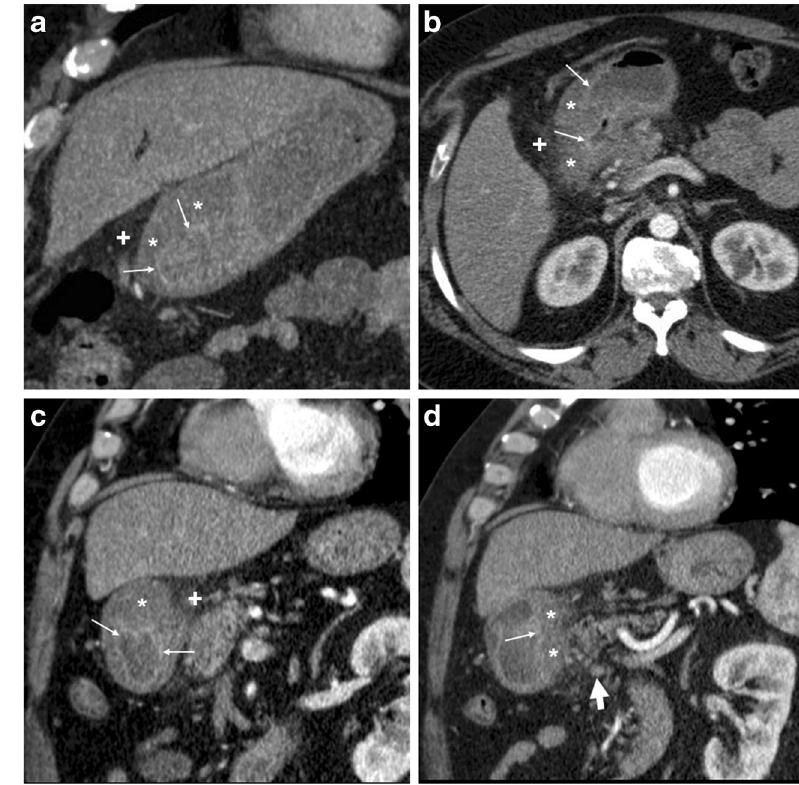
Fig. 2 An elderly 87-year-old male underwent emergency contrast- enhanced CT to investigate acute abdominal pain with epigastric tenderness but no peritonism: the antropyloric region showed pronounced, stratified mural thickening with oedematous submucosa